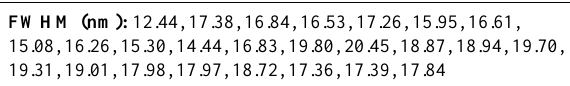
Table 1. Spectral settings of the hyperspectral camera The camera was mounted in a quadcopter UAV, model UX4.